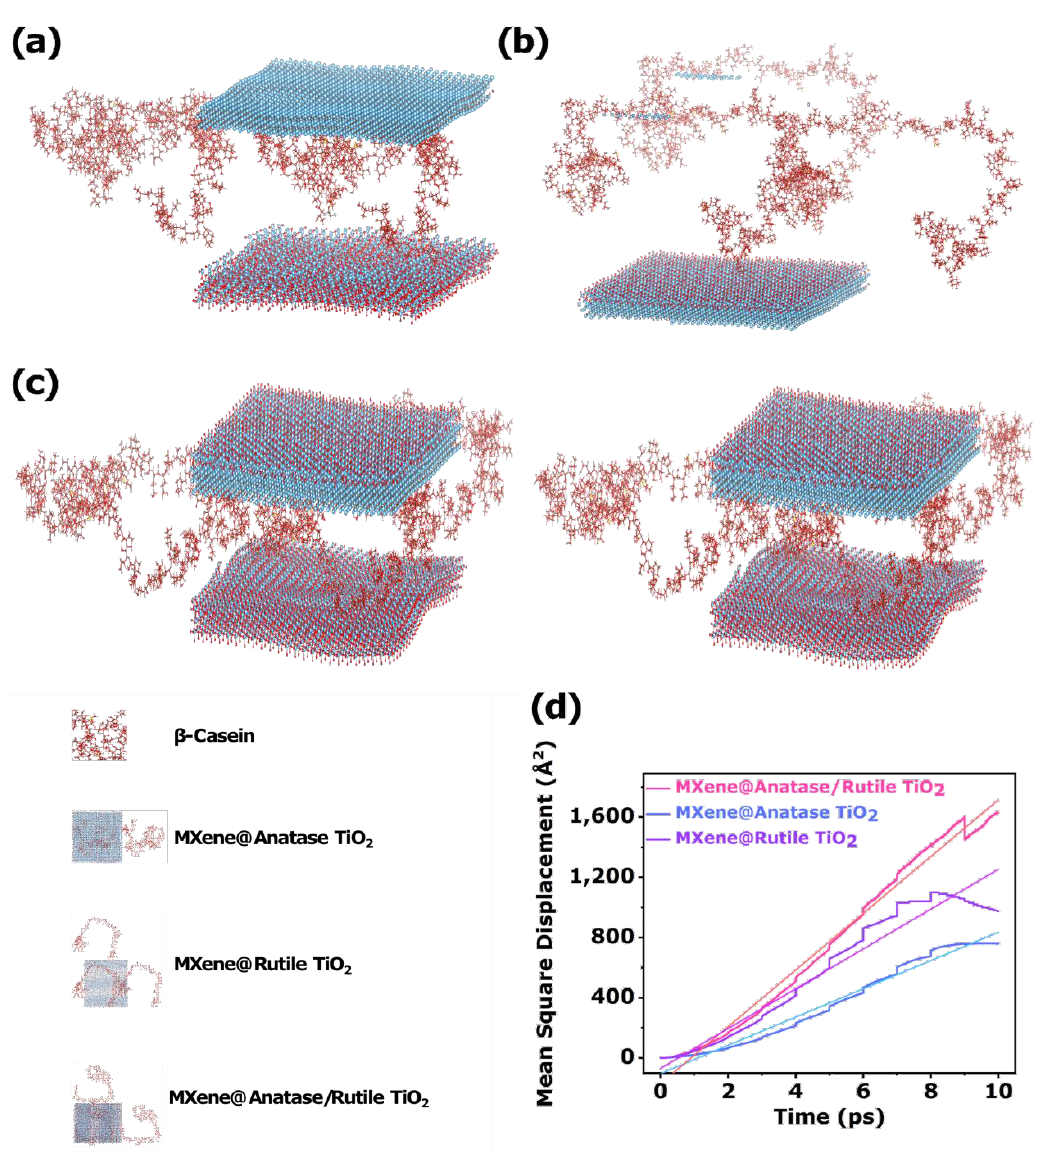
Figure 8. Model diagram of DFT synergistic effect of ( a ) MXene@anatase TiO 2 , ( b )Mxene@rutile TiO 2 , and ( c ) MXene@anatase/rutile TiO 2 heterojunction on β -Casein. ( d ) Mean square displacement during molecular dynamics simulation of MXene@anatase TiO 2 , MXene@rutile TiO 2 , and